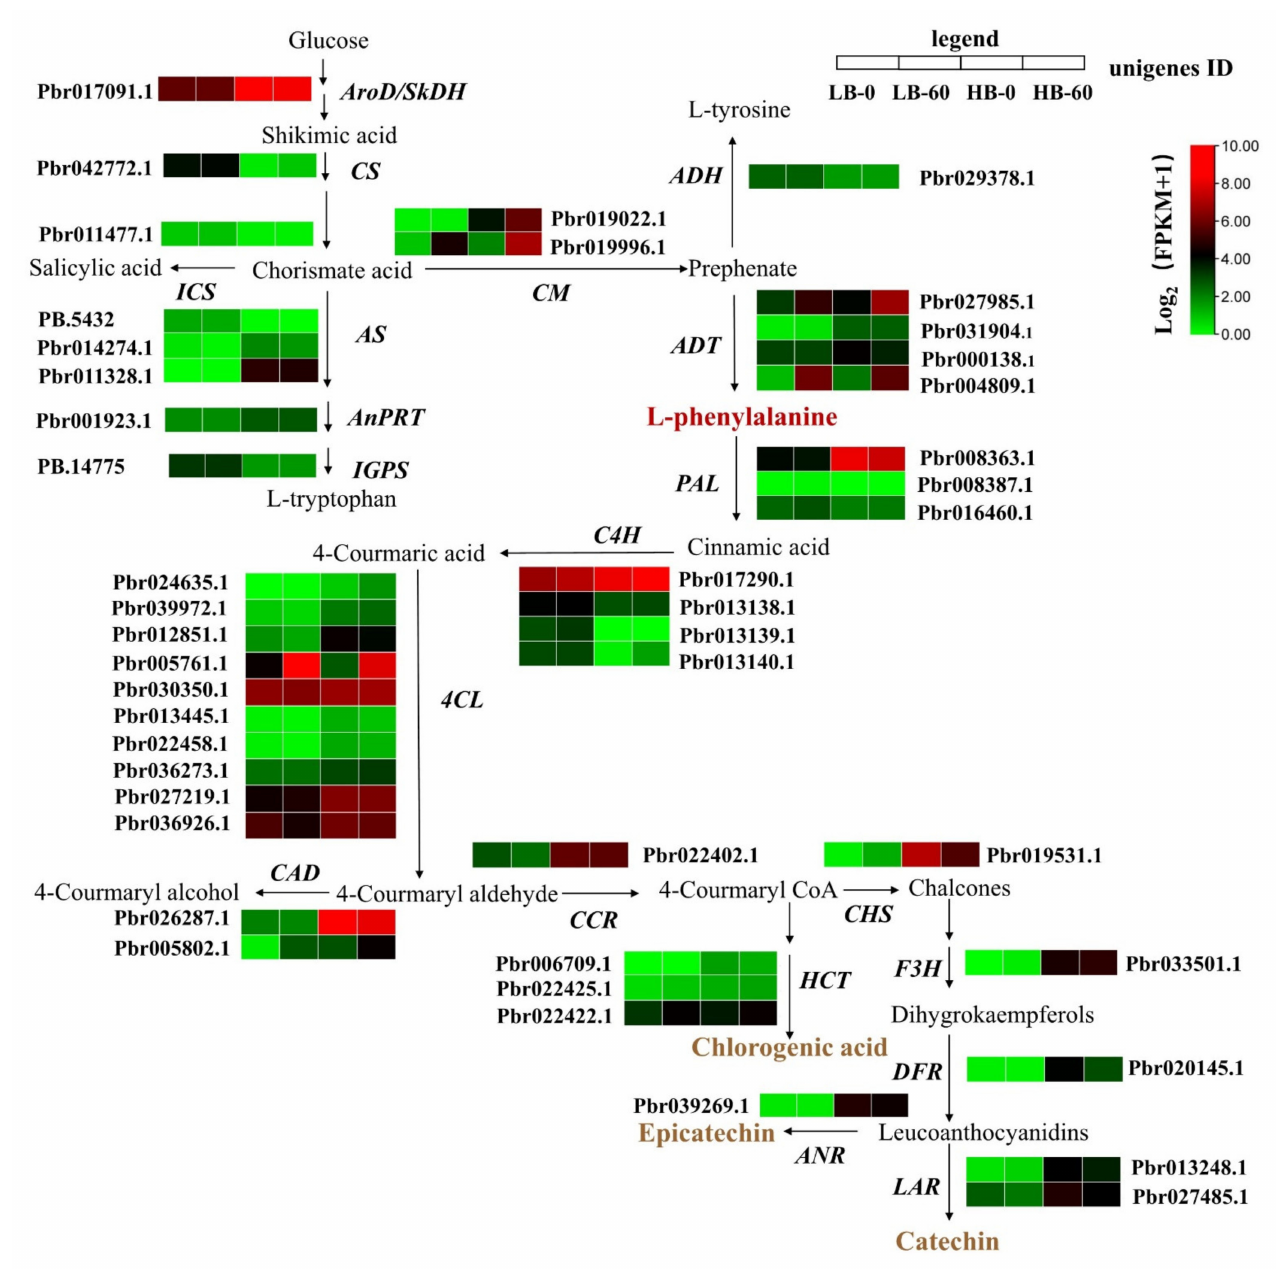
Figure 5. Heat map diagrams of relative expression levels of phenylpropanoid and flavonoid biosynthesis-related genes in two sand pear cultivars at 0 h and 1 h. LB: Low browning cultivar, HB: high browning cultivar, AroD/SkDH : 3- dehydroquinate dehydratase/shikimate dehydrogenase, CS : chorismate synthase, ICS : isochorismate synthase, CM : cho- rismate mutase, AS : Anthranilate synthase, AnPRT : anthranilate phosphoribosyl transferase, IGPS : indole-3-glycerol phosphate synthase, ADH : arogenate dehydrogenase, ADT : arogenate dehydratase, PAL : phenylalanine ammonia-lyase, C4H : cinnamate 4-hydroxylase, 4CL : 4-coumaroyl: CoA ligase, CAD : cinnamyl alcohol dehydrogenase, CCR : cinnamoyl-CoA reductase, CHS : chalcone synthase, HCT : shikimate O-hydroxycinnamoyl transferase, F3H : flavanone 3-hydroxylase, DFR : dihydroflavonol 4-reductase, LAR : leucoanthocyanidin reductase, ANR : anthocyanidin